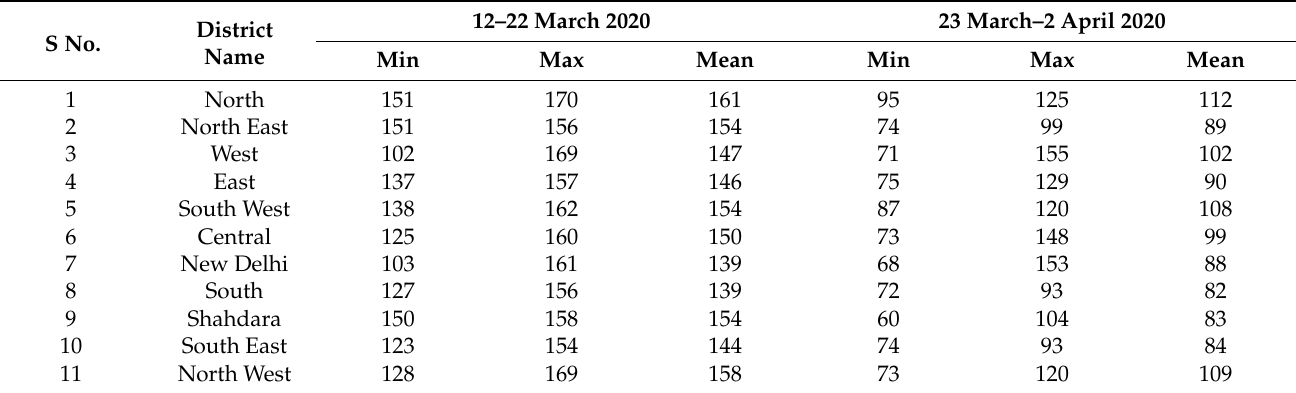
Table 4. District-wise comparison of AQI for PM 2.5 .